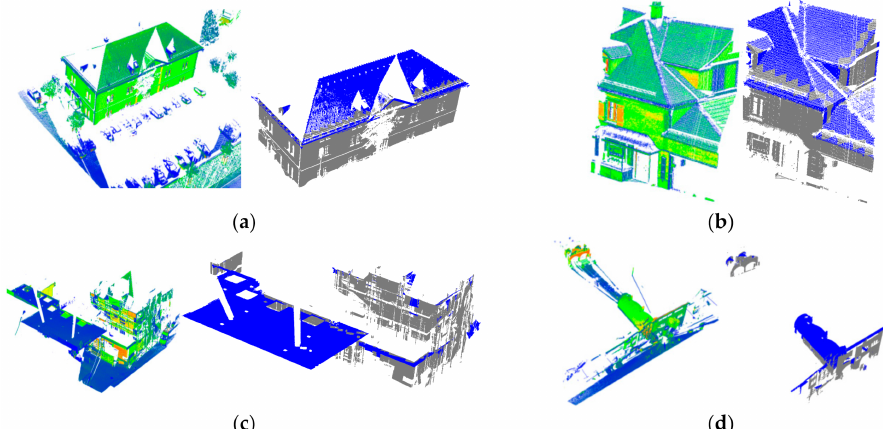
Figure 17. Extraction details of building components with a small DoPP in Semantic3D. ( a , b ) show extraction results of roofs; ( c , d ) show extraction results of porch and corridor. For each sub-figure, on the left is shown the original points rendered by intensity, on the right the extraction result with facade points colored gray and roof points colored blue.